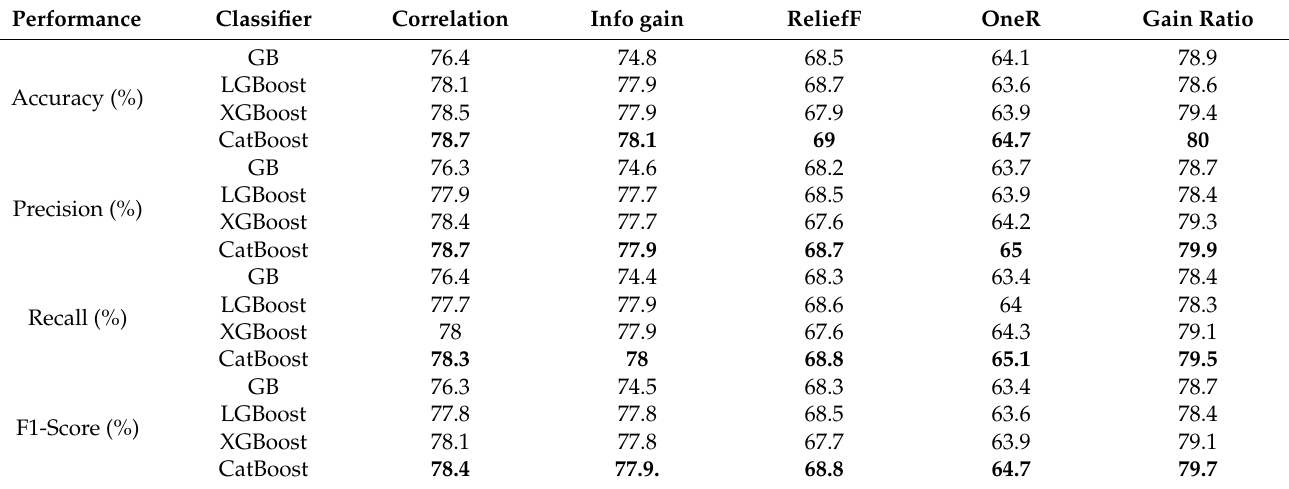
Table 6. Results of Cluster Centroid to each feature selection